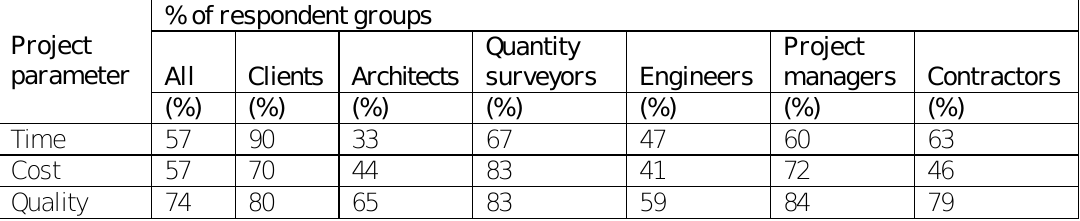
Table 1: Perceived extent to which clients are realistic, all or most of the time, with respect to their expectations of project time, cost and quality at the outset of the